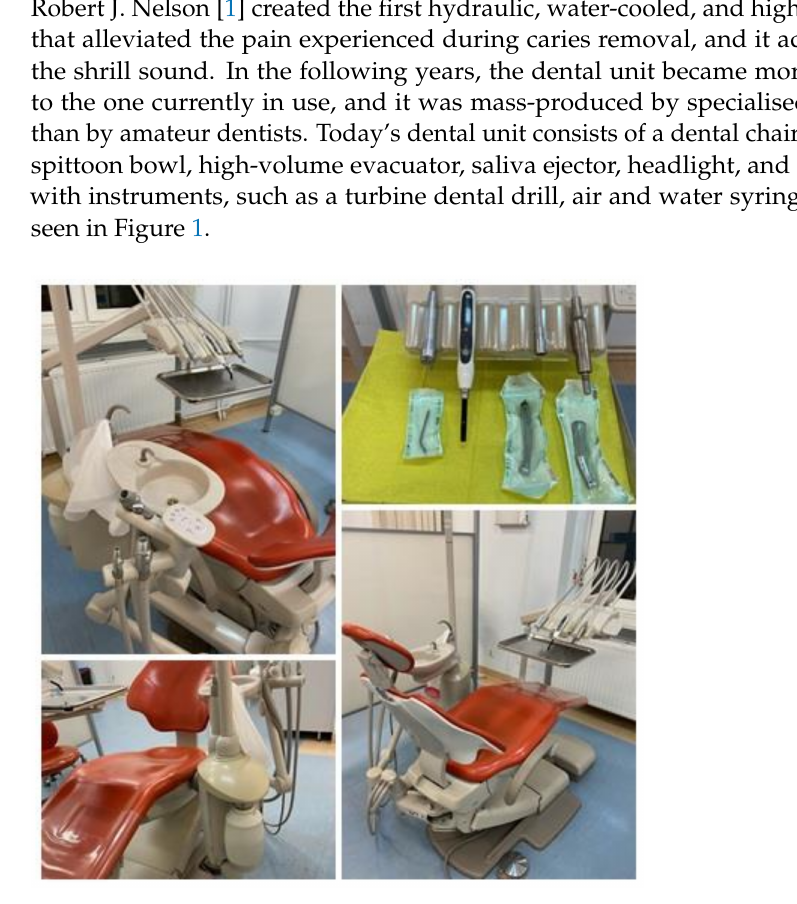
Figure 1. Single dental unit with essential